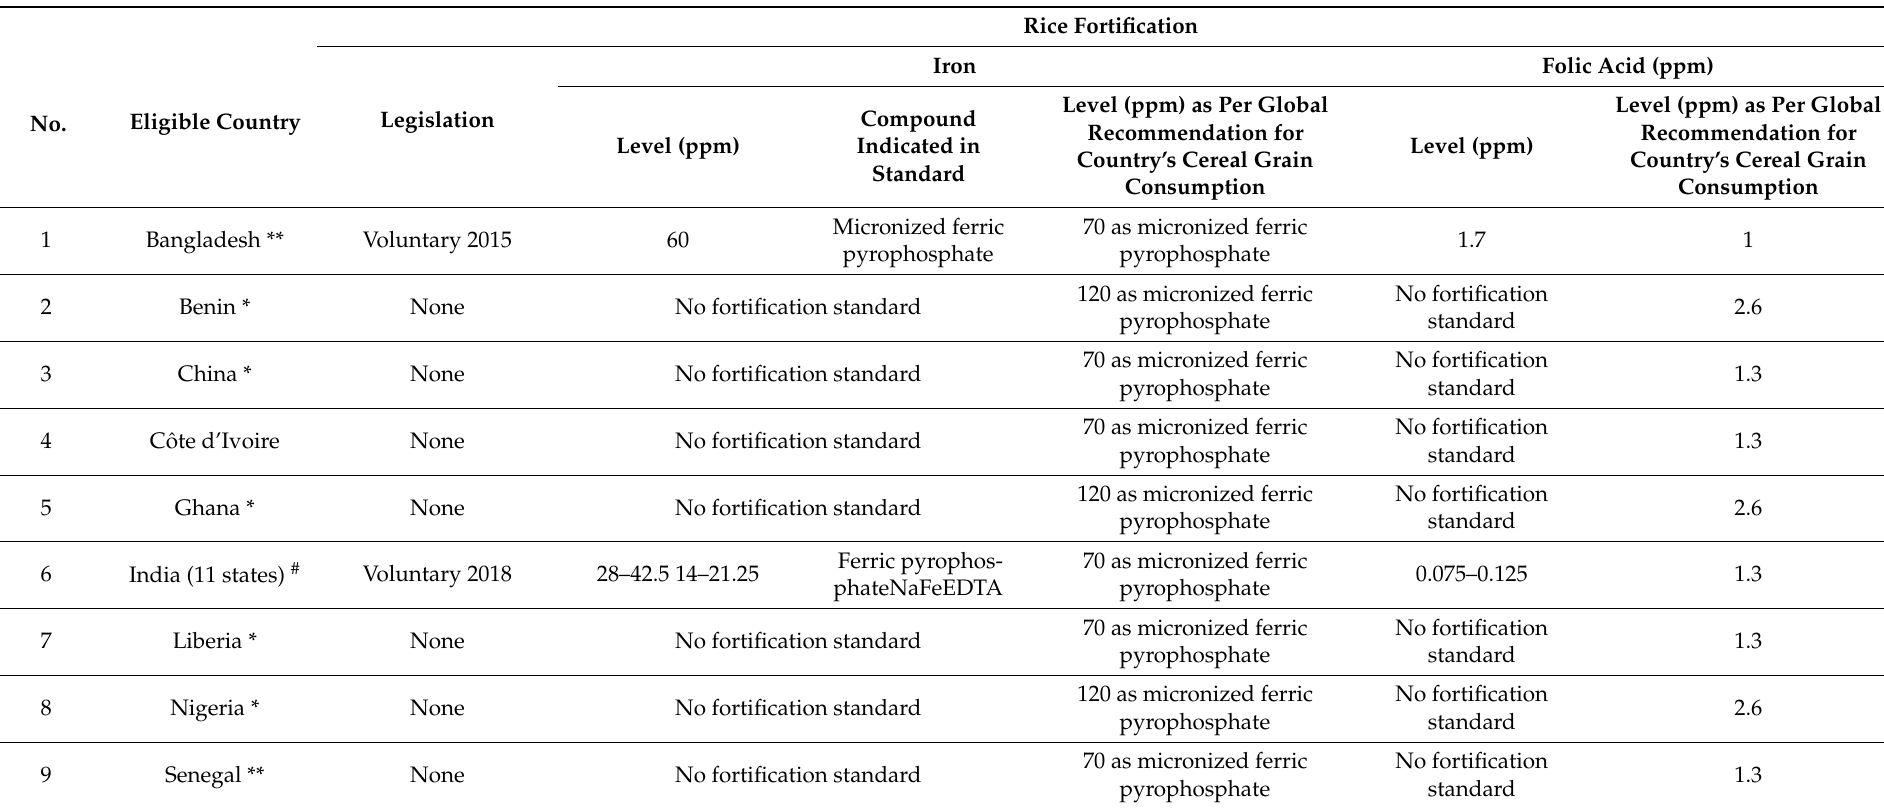
Table 4. Eligible countries that could have a high potential impact through rice fortification: information pertaining to legislative status and inclusion of iron and folic acid in fortification